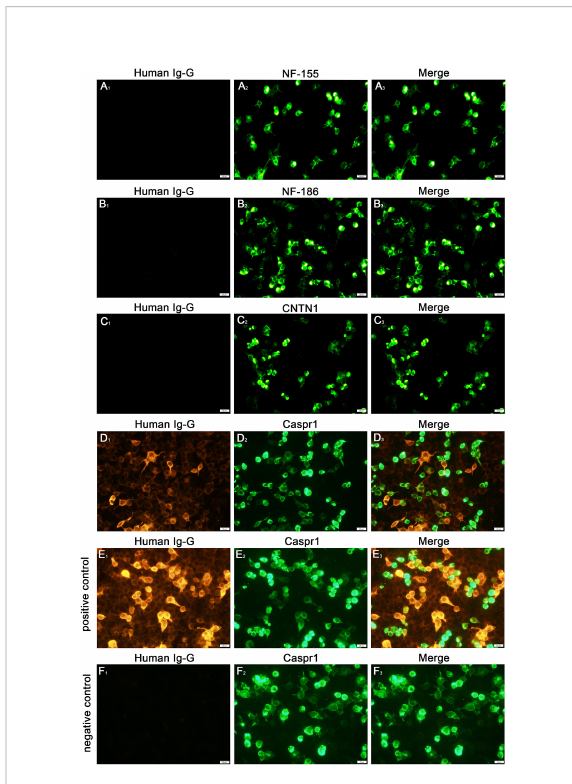
FIGURE 3 Detection of anti-NF155, NF186, CNTN1 and Caspr1 antibodies (A-D) . Cell-based assays revealed a positive fi nding for the anti-Caspr1 antibody (1:10) in serum (D) , the (E, F) were the positive and negative control of the anti-Caspr1 antibody. The positive control group used the serum of patient with positive anti-Caspr1 antibody and the negative control group used the serum of patient with negative anti- Caspr1 antibody. All the patients ’ serum (1:10) were preabsorbed with an HEK293 cell pellet for 1h at room temperature, followed by incubation with corresponding orange fl uorescently-labeled secondary goat against human IgG antibodies(Beijing, Biosynthesis Biotechnology Co., Ltd) 1.5h at room temperature. Scale bar = 20